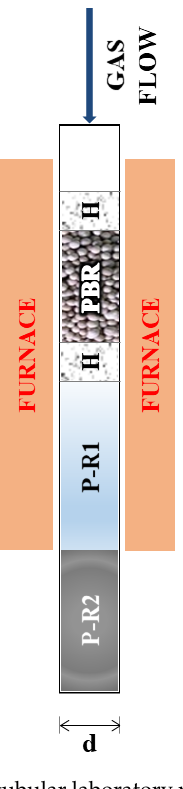
Figure 1. Schematic representation of the tubular laboratory reactor. PBR stands for packed bed reactor, P-R1 and P-R2 indicate the post reactor sections, H are the holders of the catalytic section, and d is the tube diameter. The same reactor geometry is employed for the MCO2 and SMR experiments.